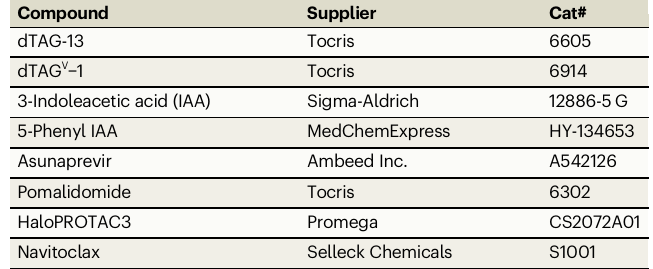
Table 2 | Antibodies used in this